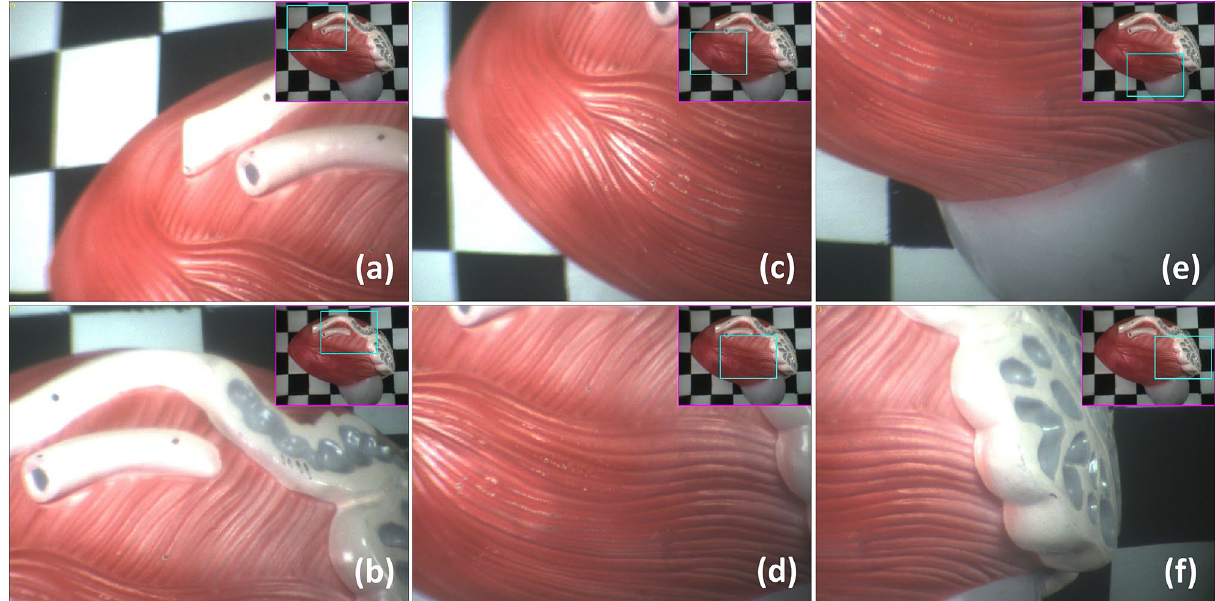
Figure 10. Demonstration of the zoomed-view panning capabilities using a urinary bladder and prostate model. The full model is visible in the wide view (upper-right-hand corner of each image set). Without moving the camera, the zoomed view was panned to descry all points of interest including the: ( a ) superior surface; ( b ) ampulla, ductus deferens, and ureter; ( c ) apex and anterior border; ( d ) inferolateral surface; ( e ) prostate base; and ( f ) seminal